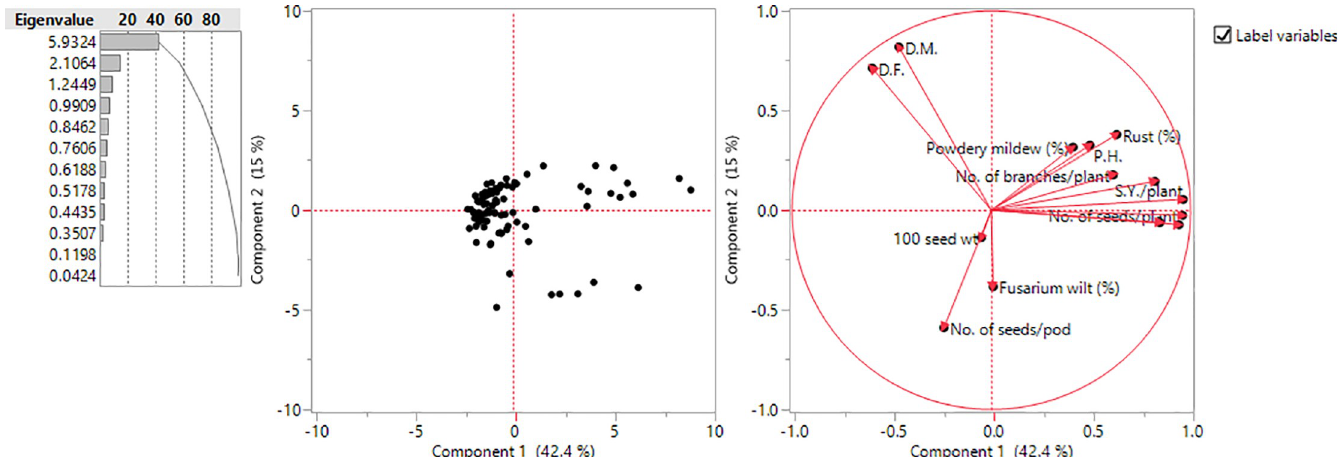
Fig 3. PCA analysis—(a) 2-D graph of first two principal components and (b) various traits contributing to the variability.